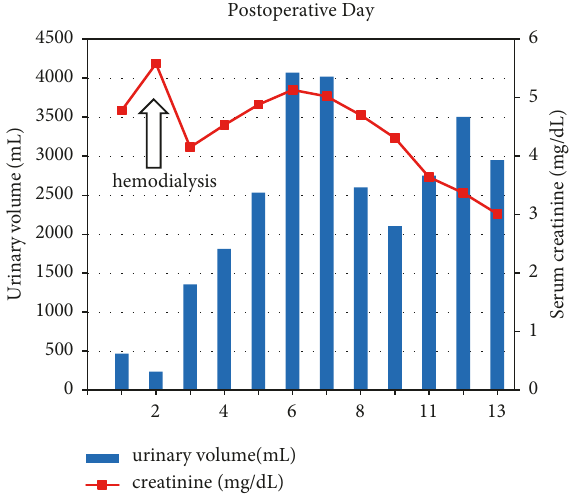
Figure 2: The clinical course of urinary volume and renal